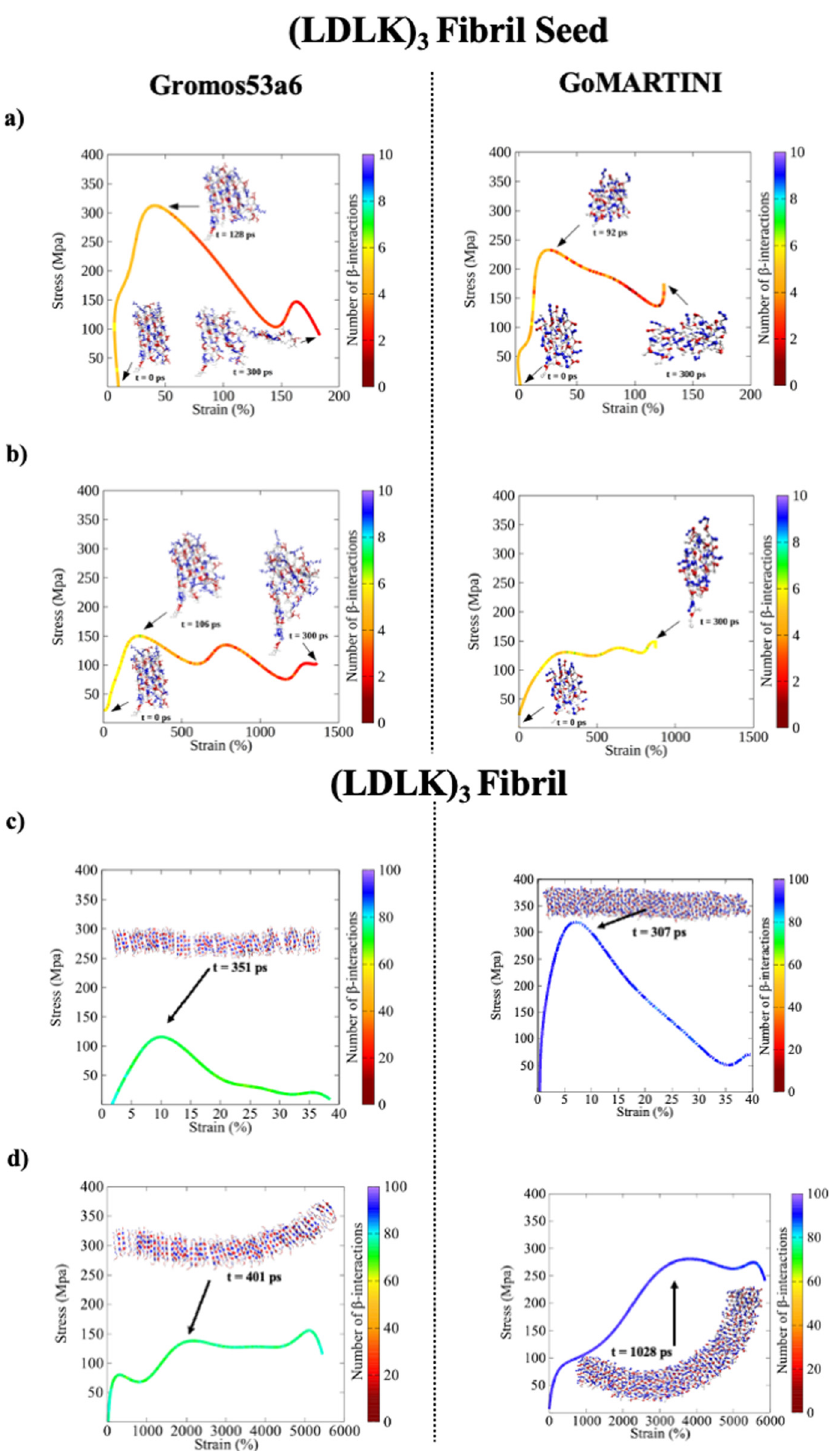
Figure 5: Computational nanomechanic characterization of ( LDLK ) 3 fi bril seeds and fi brils. Mechanical failure of SAP fi bril seeds and fi